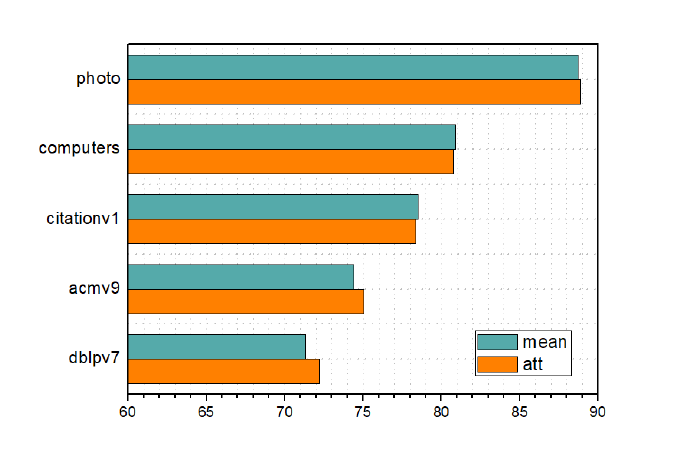
Figure 5. The performance comparison when using different aggregators to formulate motif proto- types. “att” and “mean” represent the attention-based and mean-based aggregators, respectively. The horizontal axis represents the classification accuracy, and the vertical axis represents the